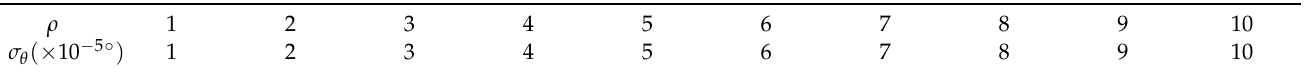
Table 6. Standard deviation σ θ against ρ at V = 10 − 4